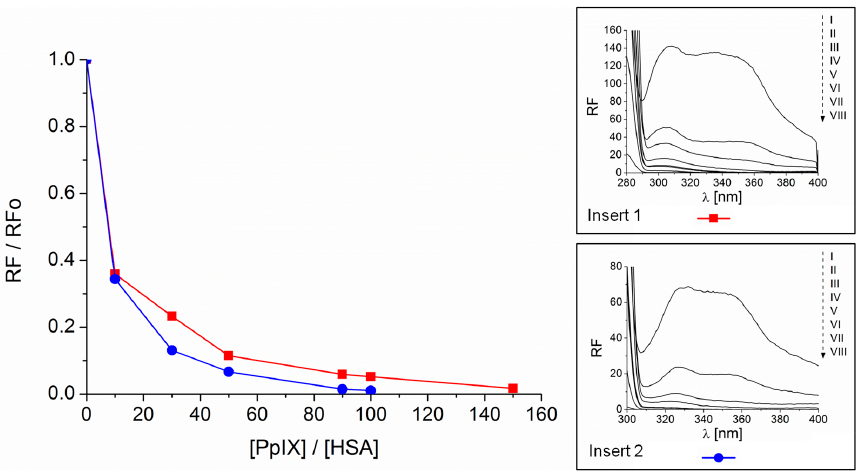
Figure2. Quenching of HSA fluorescence by PpIX obtained for 280 nm ( ▬ ■ ▬ ) and 295 nm ( ▬ ● ▬ ) excitation wavelength. In the inserts: fluorescence emission spectra of HSA at concentration 1 × 10 − 6 M (I) and HSA in the presence of increasing PpIX concentration in range from 1 × 10 − 5 M to 3 × 10 − 4 M (II, III, IV, V, VI, VII, VIII) excited at 280 nm (Insert 1) and 295 nm (Insert 2).